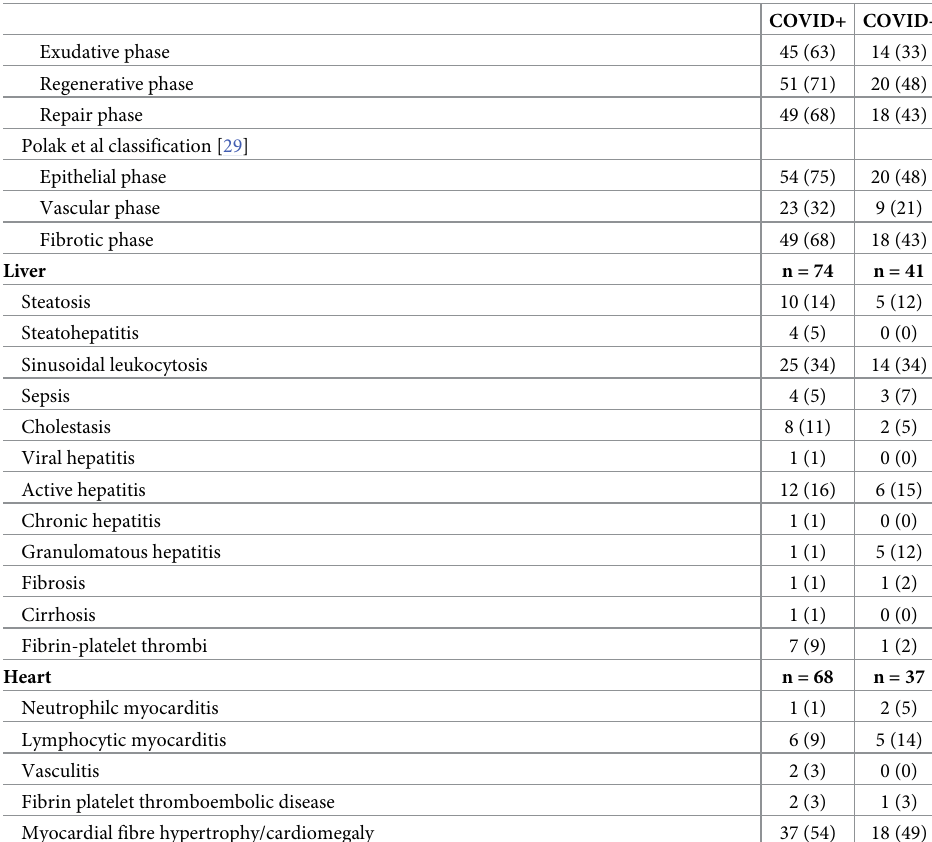
Table 4 presents results on post-mortem lung TaqMan Array Cards (TAC) and Mycobacte-